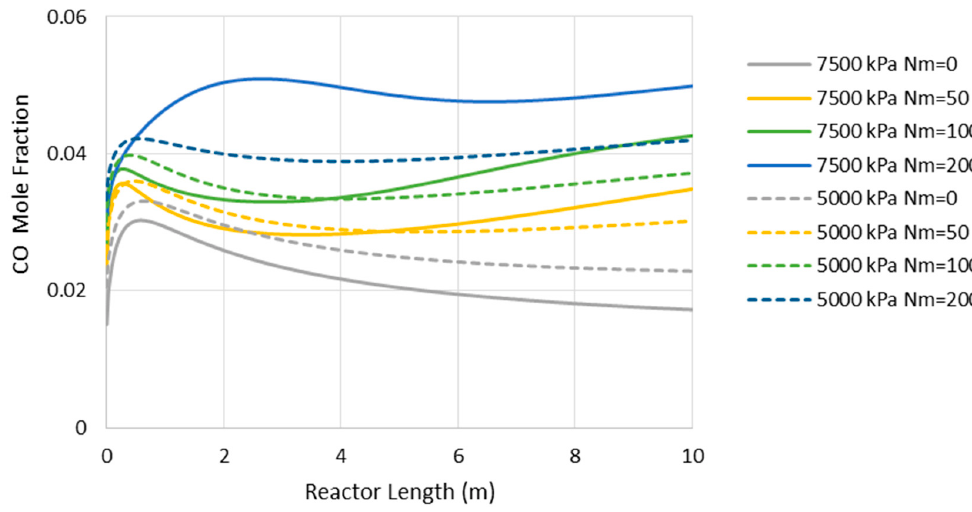
Figure 8. CO mole fraction through the isothermal reactor length (Nm = 0 corresponds to CR).